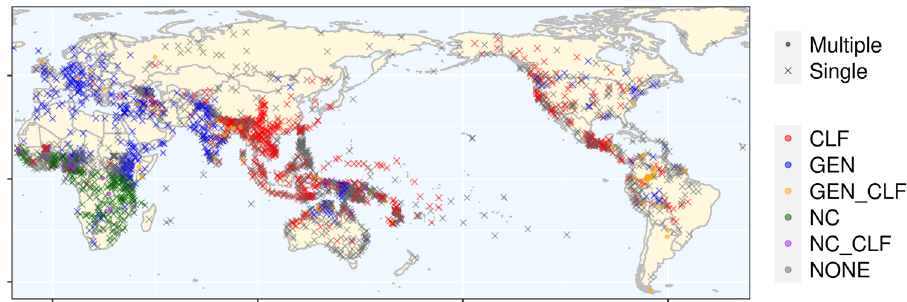
Fig. 1 Nominal classi fi cation systems in languages of the world. The abbreviations are interpreted as follows. CLF classi fi er, GEN gender, NC Noun Class. Note that Gender and Noun Class are mutually exclusive according to our coding policy (see Supplementary